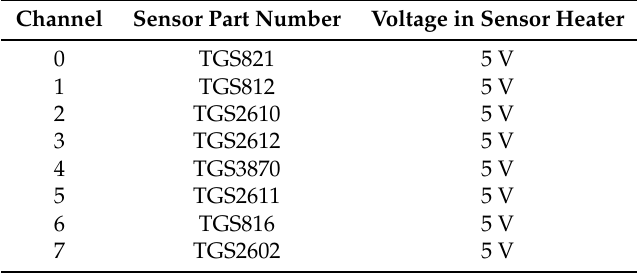
Table 1. Types of metal oxide semiconductor (MOS) sensors (provided by Figaro Inc.)